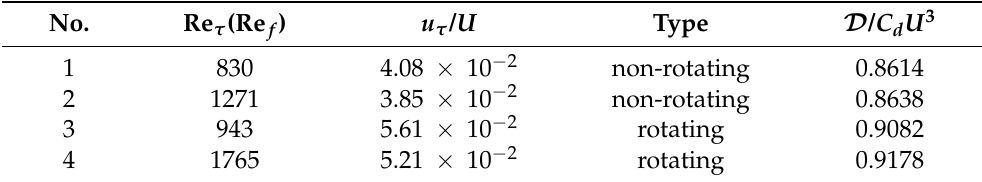
(cid:112) τ b / ρ 0 ≡